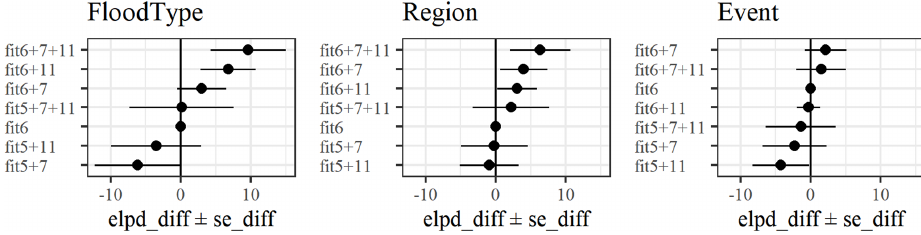
Figure 1. Comparison of model candidates by their difference in ELPD-LOO using combinations of the first five predictors (fit5) plus predictors 6, 7, and 11, along with their differences and the standard error of the differences with reference to candidate model “fit6” for each model variant.